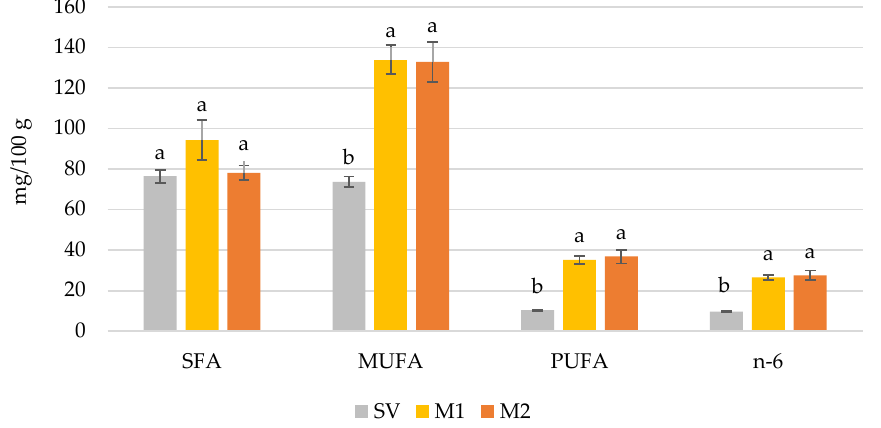
Figure 2. Content (mg/100g of wet tissue) of the sum of saturated (SFA), monounsaturated (MUFA), polyunsaturated (PUFA) and n-6 fatty acids in unmarinated sous-vide (SV) and marinated with M1 (Old Polish) and M2 (Bordeaux) marinades semimembranosus muscle from Holstein-Friesian bulls. a,b —different letters indicate significant at p < 0.05 differences between values for each sum of fatty acid; vertical bars refer to standard error of the mean (SEM). SFA—the sum of the concentration of C14:0, C15:0, C16:0, C17:0, C18:0, C20:0, C22:0; MUFA the sum of the proportion of C14:1, C16:1,